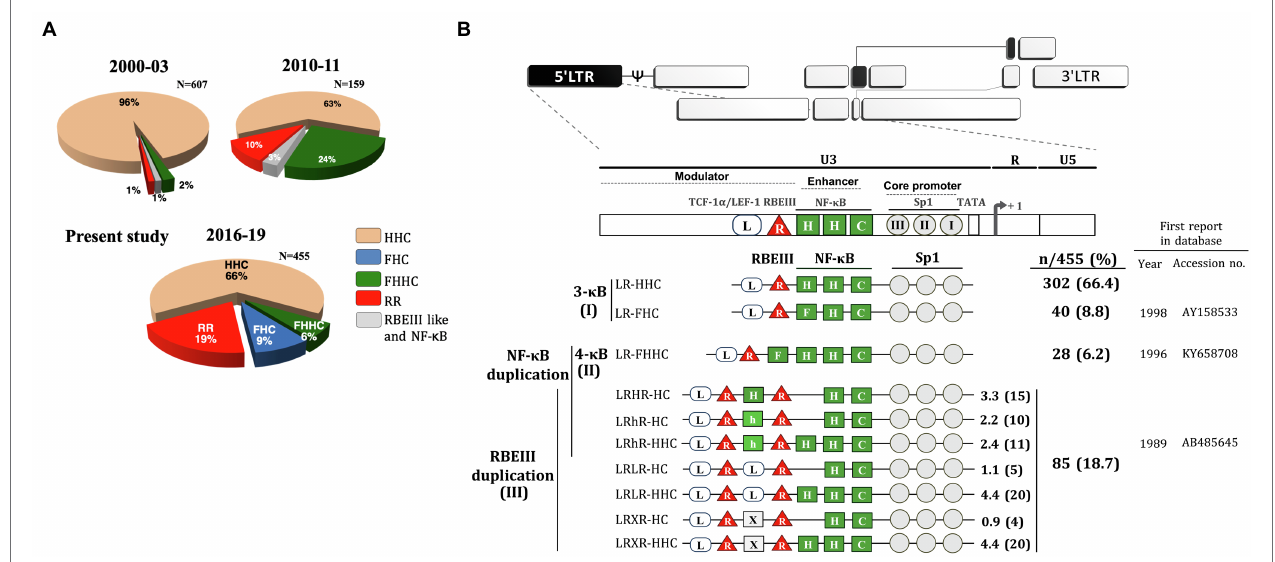
FIGURE 1 | Profile of HIV-1C promoter variants in the Indian population. (A) The time of sample collection, sample number, and the nature of the promoter configuration are illustrated. The pie charts represent the percentage prevalence of the variant viral strains as color-coded – canonical HHC (beige), FHC (blue), FHHC (green), RR (duplication of RBEIII; red), and duplication of RBEIII like and NF- κ B (grey). The data for the periods 2000–2003 and 2010–2011 are adapted from Bachu et al. (2012a) and replotted. The data of the present study are presented in the pie chart 2016–19. (B) The magnitude of TFBS variation in HIV-1C LTR. The upper panel represents the genome organization of HIV-1 followed by the TFBS arrangement in the canonical HIV-1C LTR. Sp1 motifs are depicted as grey circles, RBEIII motifs (R) as red triangles, and TCF-1 α /LEF-1 sites (L) as open rectangular boxes. The various types of NF- κ B binding sites (H, C, F, and h) are depicted as green square boxes. The various HIV-1C viral strains are classified into three main categories based on the NF- κ B and/or RBEIII motif duplication. (I) The 3- κ B LTR viral strains. (II) The canonical 4- κ B LTR viral strains. (III) The viral strains containing the RBEIII site duplication. The two RBEIII sites are separated by an interceding sequence that constitutes an additional copy of a κ B-motif (H), κ B-like motif (h), TCF-1 α /LEF-1 motif (L), or sequence without a distinct pattern (X). The analysis represents 455 of the 518 LTR sequences, and we could not type 63 other